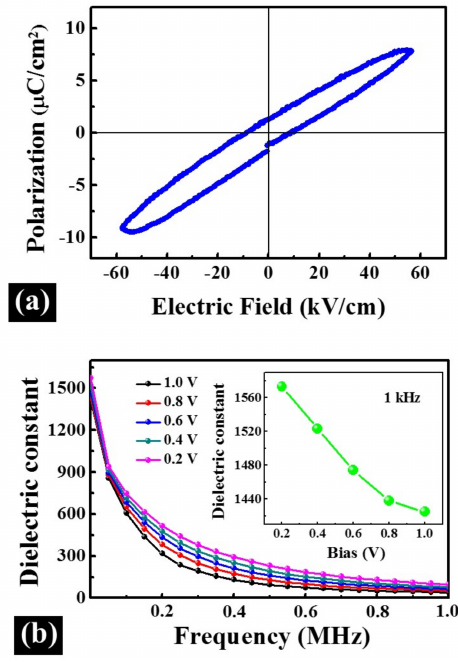
Figure 10. Refractive index ( a ); and extinction coefficient ( b ) of PLZT thin films annealed at various oxygen pressure as a function of wavelength in a range of 300–1000 nm. ( c ) The reflectance spectra of the MgO substrate and PLZT thin films at different annealing oxygen pressure over the wavelength range between 300 and 1000 nm. ( d ) The plot of the corresponding average reflectance of the pristine MgO substrate and PLZT thin films.